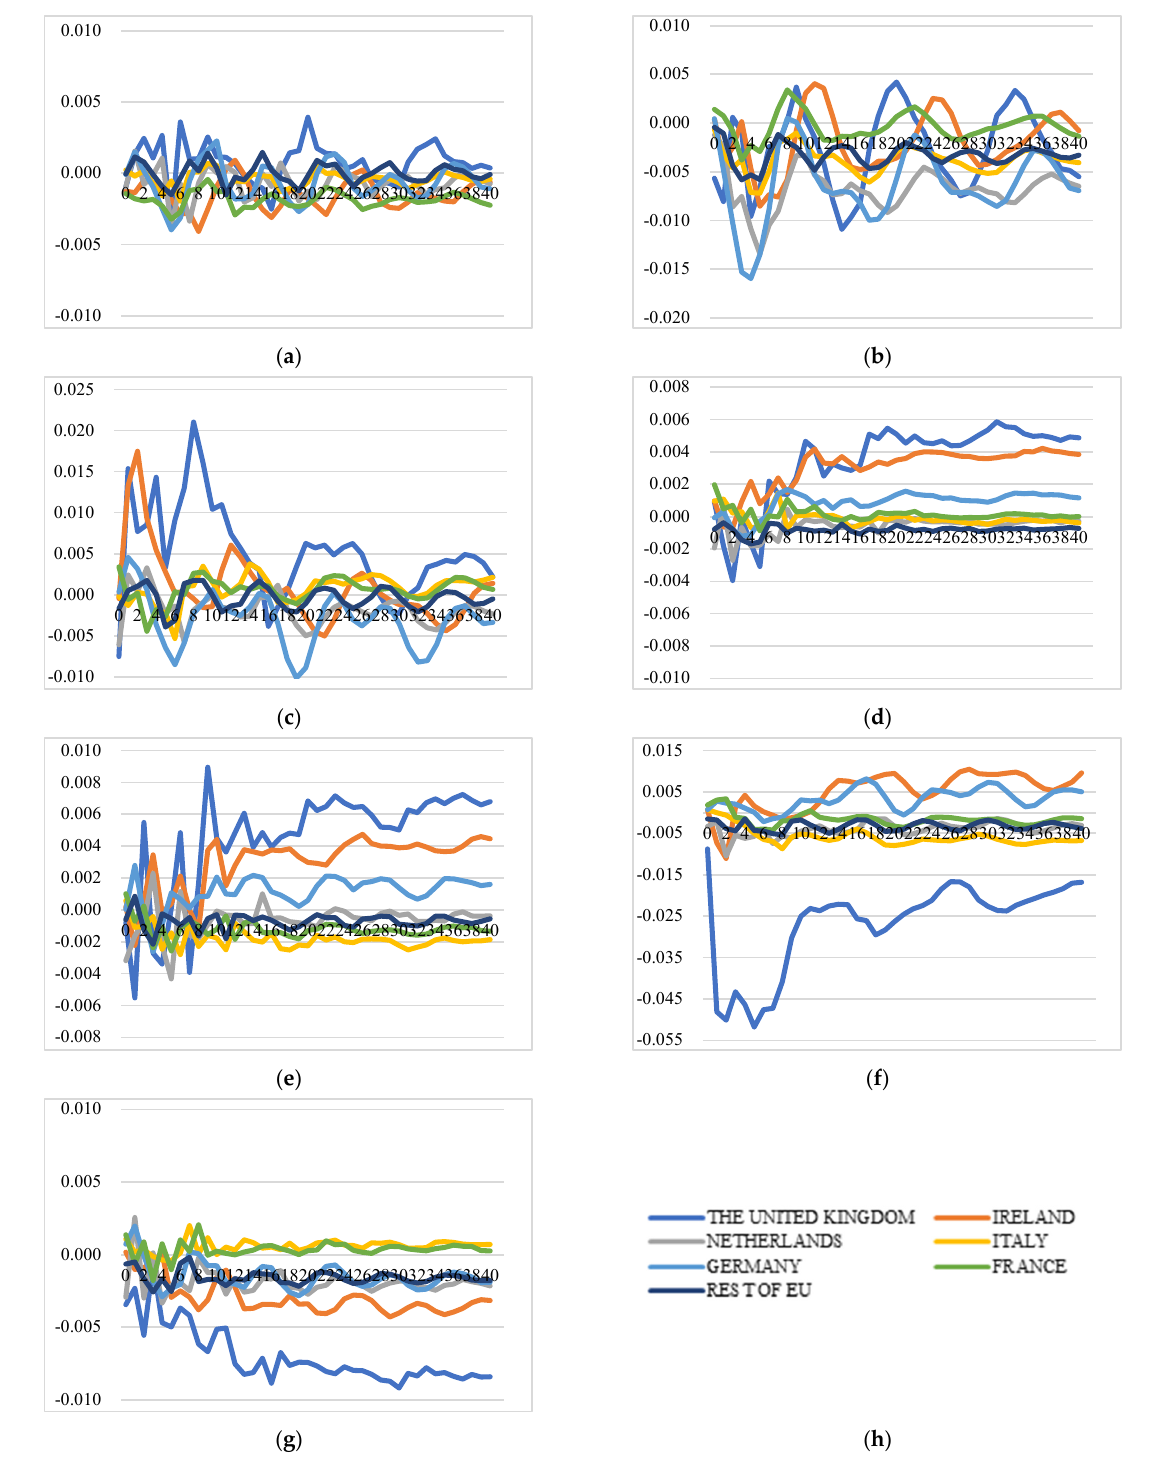
Figure 14. Generalized impulse response functions (GIRFs) of six EU member states’ extra-EU cheese export prices after a negative one-standard-error shock to cheese production (bootstrap median estimates). ( a ) GIRFs after a shock to France’s cheese production. ( b ) GIRFs after a shock to Germany’s cheese production. ( c ) GIRFs after a shock to Ireland’s cheese production. ( d ) GIRFs after a shock to Italy’s cheese production. ( e ) GIRFs after a shock to the Netherlands’ cheese production. ( f ) GIRFs after a shock to the UK’s cheese production. ( g ) GIRFs after a shock to the rest of the EU’s cheese production. ( h )